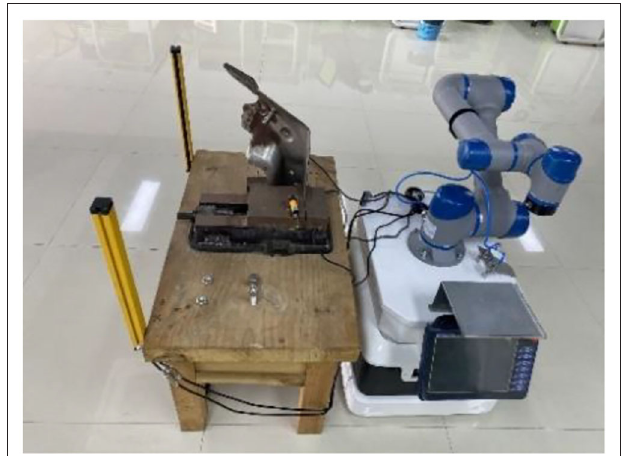
FIGURE 6 | Cooperative assembly task in the